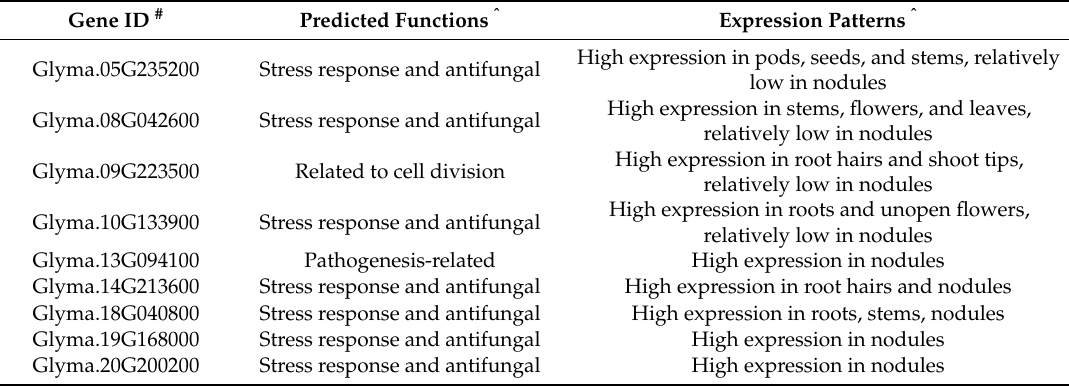
Table 4. NCR-like proteins in soybean and their predicted